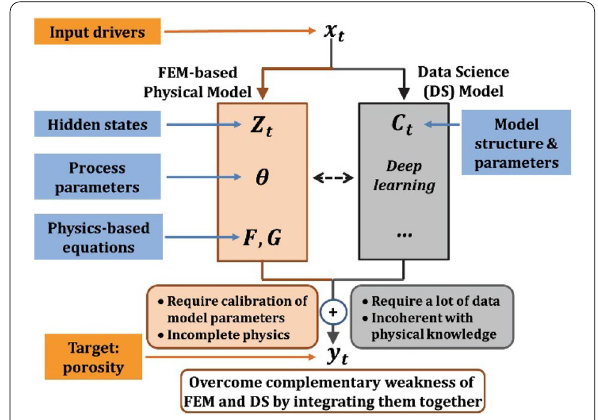
Figure 14 Integration of physical model and neural network